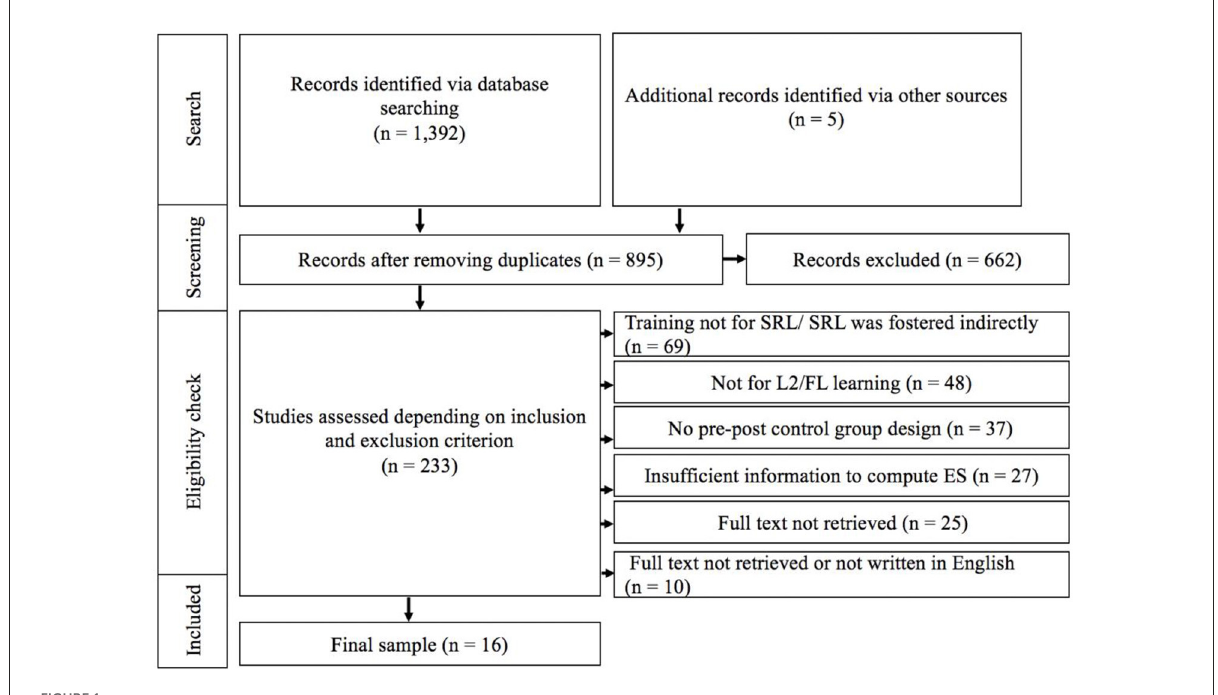
FIGURE1 Overview of literature search